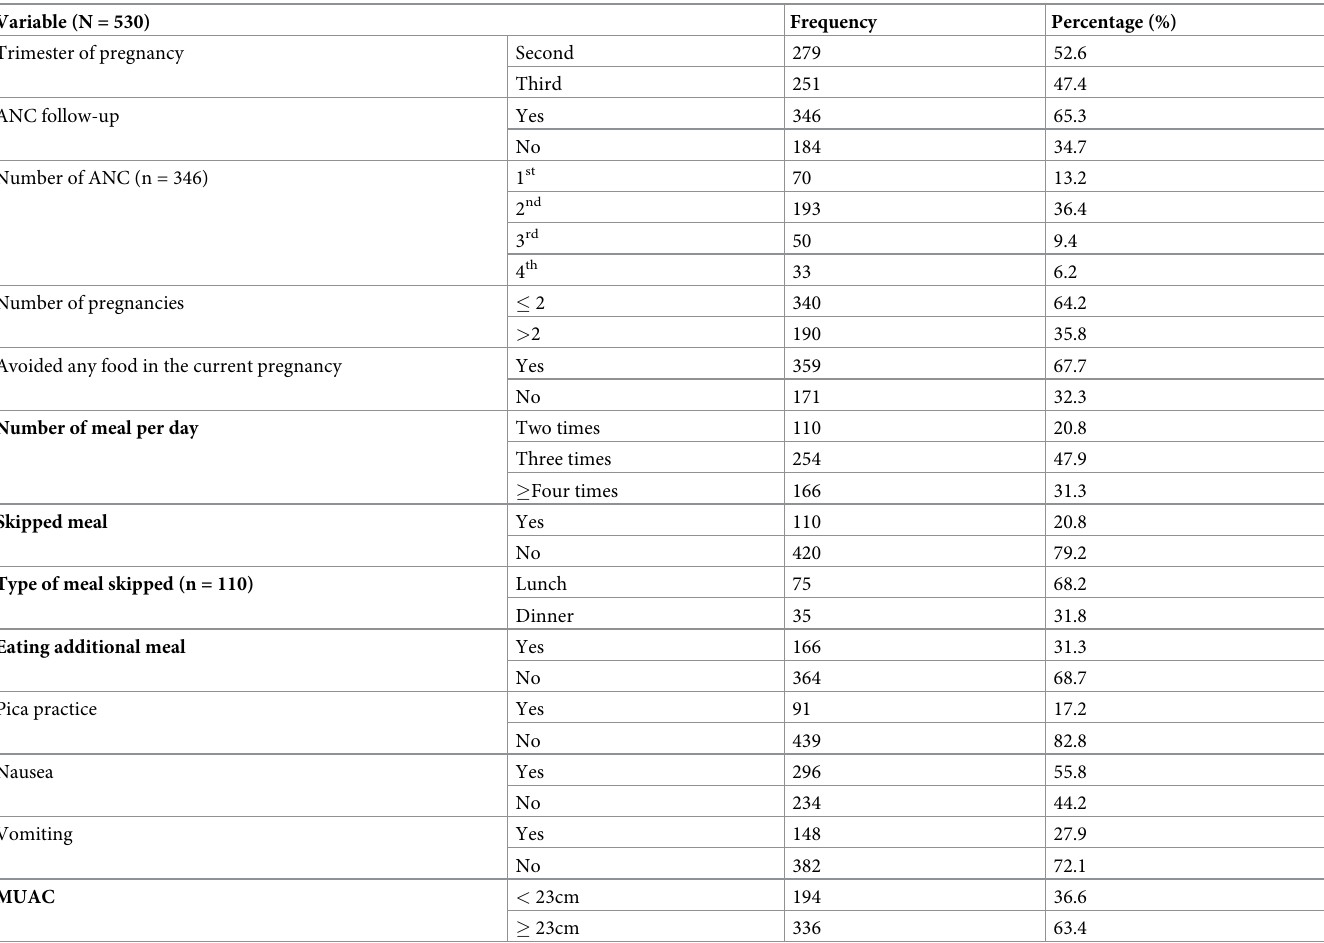
Table 2. Pregnancy, meal pattern and anthrpometric characteristics of pregnant women Sidama Region, Southern Ethiopia 2021. Variable (N =